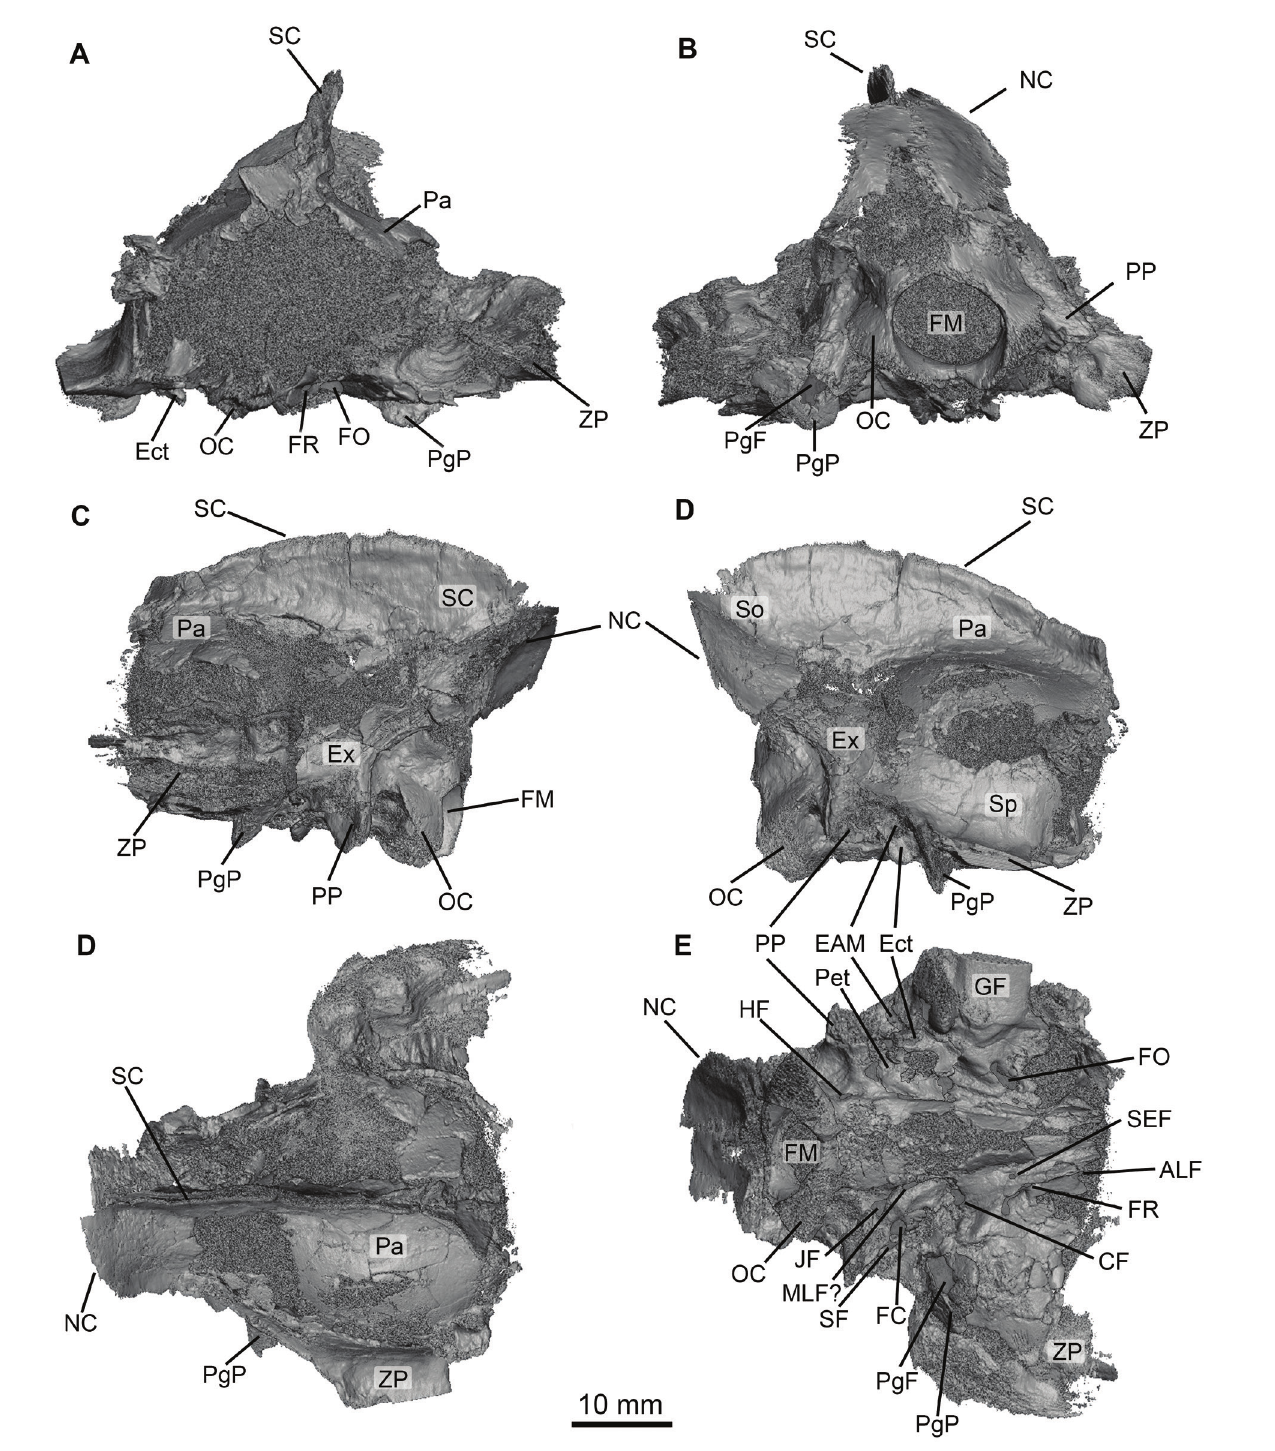
Figure 2. CT renderings of the basicranium of SDSNH 47878 in six orientations. Some features are outlined in black or shaded grey for emphasis. Junctions between bones are not outlined when the boundaries are indistinct. A, rostral view; B, caudal view; C, left lateral view, rostral direction left; D, right lateral view, rostral direction right; E, dorsal view, rostral direc- tion right; F) ventral view, rostral direction right. Abbreviations: ALF, anterior lacerate foramen; CF, condylar foramen; EAM, external auditory meatus; Ect, ectotympanic; Ex, exoccipital; FC, fenestra cochleae; FM, foramen magnum; FO, foramen ovale; FR, foramen rotundum; GF, glenoid fossa; HF, hypoglossal foramen; JF, jugular foramen; MLF, middle lacerate fora- men; NC, nuchal crest; OC, occipital condyle; Pa, parietal; Pet, petrosal; PgF, postglenoid foramen; PgP, postglenoid process; PP, paroccipital process; SC, sagittal crest; SEF, sphenoidal emissary foramen; SF, stylomastoid foramen; So, supraoccipital; Sq, squamosal; ZP, zygomatic